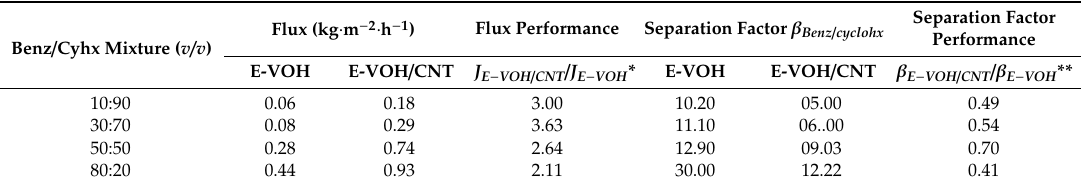
Table 7. Total flux and separation factors obtained with the E-VAL and E-VOH-CNT membranes during 3 h of the separation process.